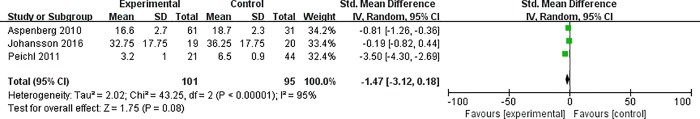
Forest plot for radiological fracture pain degree.